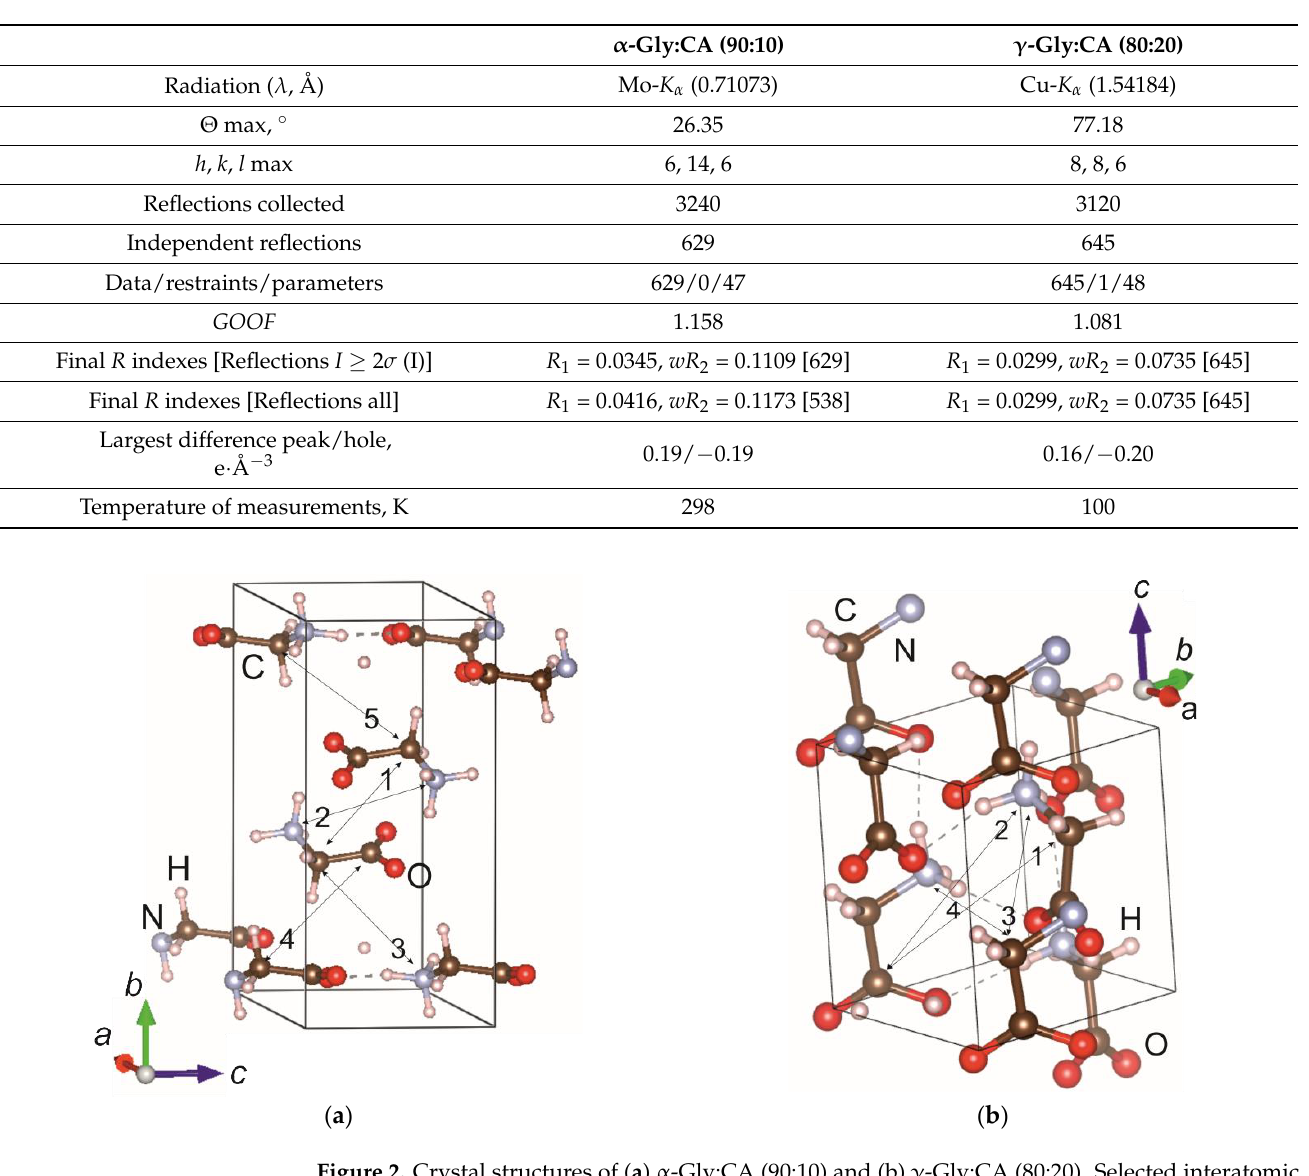
Table 3. Comparison of unit cell parameters a , c , and unit cell volume V cell in γ -Gly:CA (80:20) and nominally pure γ -Gly crystals from [53,54].